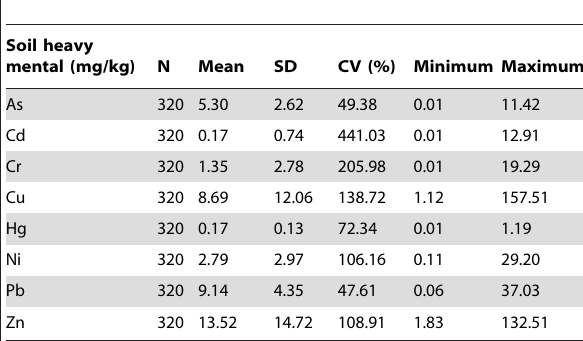
Table 2. Soil heavy mental statistics of township in Taiwan,